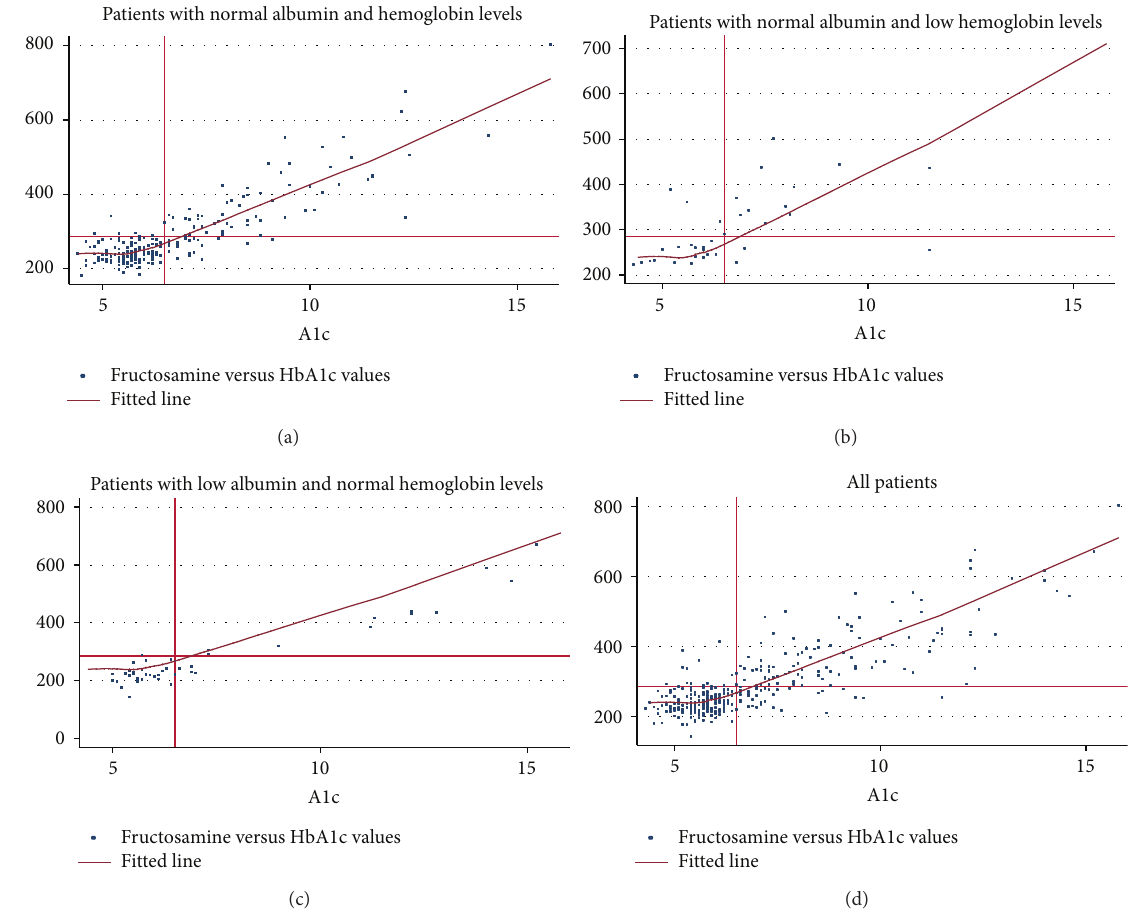
Figure 1: The plots show HbA1c and fructosamine values from our sample. Superimposed on the graph are the lines at the threshold between normal and abnormal fructosamine values (fructosamine = 285) and normal and abnormal HbA1c values (HbA1c = 6.5). (a) plots HbA1c and fructosamine values from patients with normal albumin and hemoglobin levels defined as being in the top 3 quartiles for hemoglobin and albumin levels. Superimposed on the graph is a LOWESS curve, which is a smoothed curve showing the central tendency at each value among those with normal albumin and hemoglobin levels. Correlation between HbA1c and fructosamine = 0.72. (b) plots HbA1c and fructosamine values from patients with low hemoglobin levels (lowest quartile) and normal albumin levels. The LOWESS line is from Figure 1(a) for those with normal hemoglobin and albumin levels. Correlation between HbA1c and fructosamine = 0.63. (c) plots HbA1c and fructosamine values from patients with low albumin levels (lowest quartile) and normal hemoglobin levels. The LOWESS line is from Figure 1(a) for those with normal hemoglobin and albumin levels. Correlation between HbA1c and fructosamine = 0.75. (d) plots HbA1c and fructosamine values from all patients. The LOWESS line is from Figure 1(a) for those with normal hemoglobin and albumin levels. Correlation between HbA1c and fructosamine =